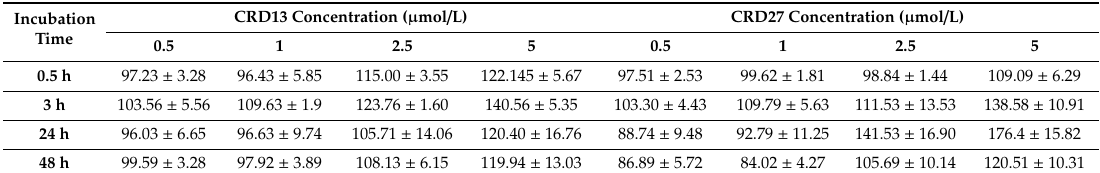
Table 3. Changes in mitochondrial potential ( ∆Ψ m) in 1301 cells under the influence of ruthenium dendrimers CRD13 and CRD27. The values are mean ±